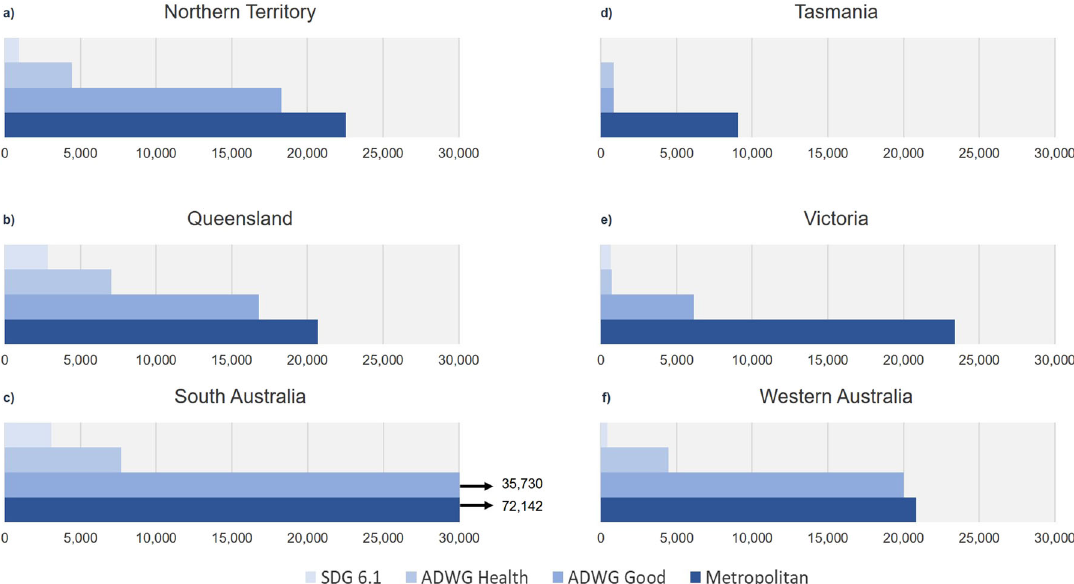
Fig. 3 Estimated populations of Australian state/territory jurisdictions where water quality service level de fi nitions were not achieved in 2018 – 2019 (towns and settlements <1000 people). a Northern Territory. b Queensland. c South Australia. d Tasmania. e Victoria. f Western Australia. Source data are provided as a Source Data fi le.